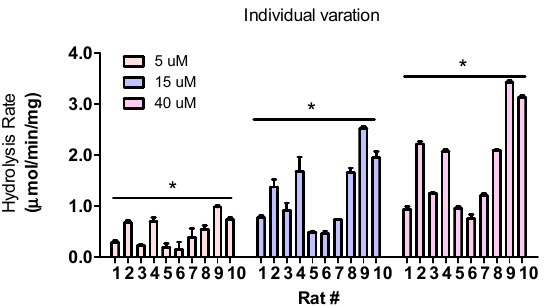
Figure 8. Wogonoside hydrolysis individual variation. Wogonoside were incubated with enzymes prepared from individual rats in KPI buffer (50 mM, pH 6.5) for 30 min at 37 ◦ C (n = 3, * p <